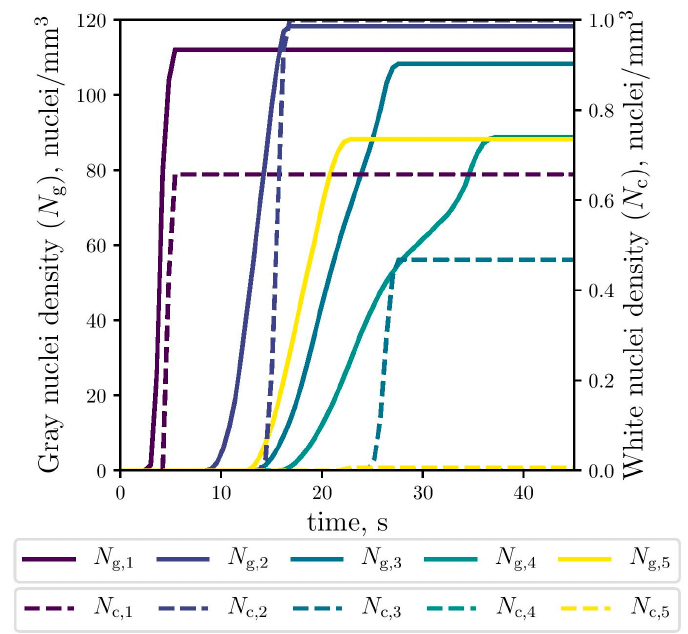
Figure 11. Simulated gray (continuous lines) and white (dashed lines) eutectic nuclei evolution at the selected points (The dashed lines of N c,4 and N c,5 were lapped with each other).